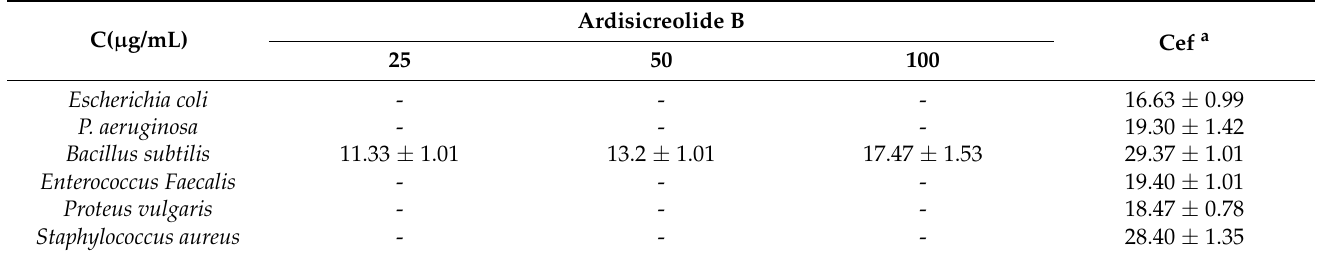
Table 2. The antibacterial activities of Ardisicreolide B. (mean ± SD, n = 3) (d, mm).